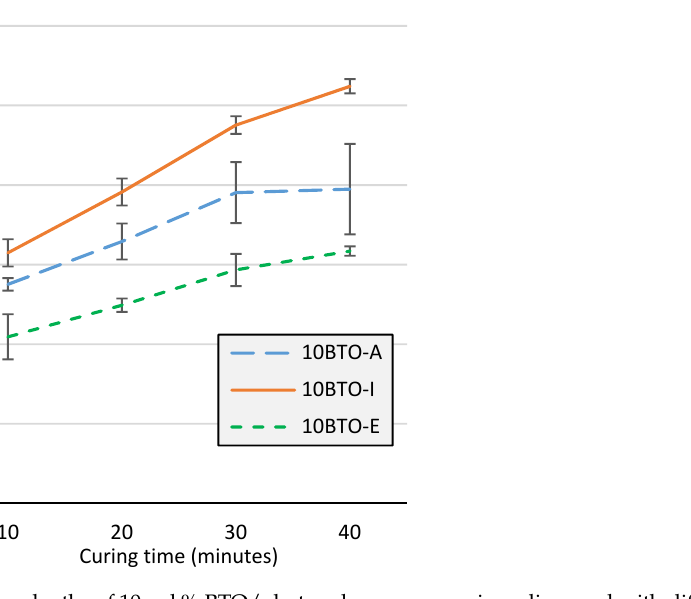
Figure 4. Curing depths of 10 vol.% BTO/photopolymer suspensions dispersed with different solvents. The lighter colors indicate ceramic particles while the darker grey colors indicate photopolymers. From the first impression, the suspensions dispersed in both acetone and ethanol show the lowest number of dark grey areas (Figure 5, shown in red circles), indicating better dispersion. Furthermore, these two composites also show a high number of single particles in the cross-section. No sedimentation of particles was observed from lower magnification images (not shown